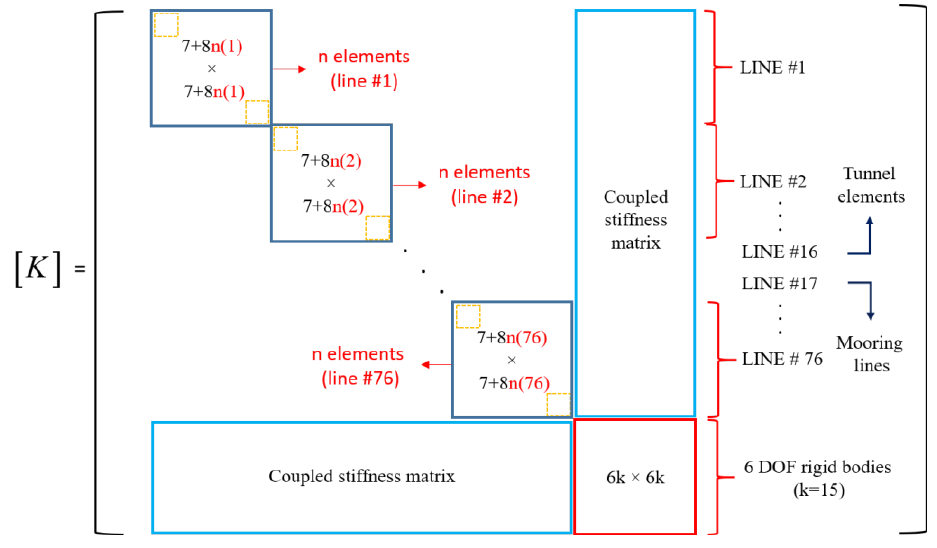
Figure 2. Stiffness matrix for the simulated SFT (line #1~#16 are for tunnel and line #17~#N are for mooring lines, n(1) means number of sub-elements of line #1, k is the number of the 6 DOF rigid body).